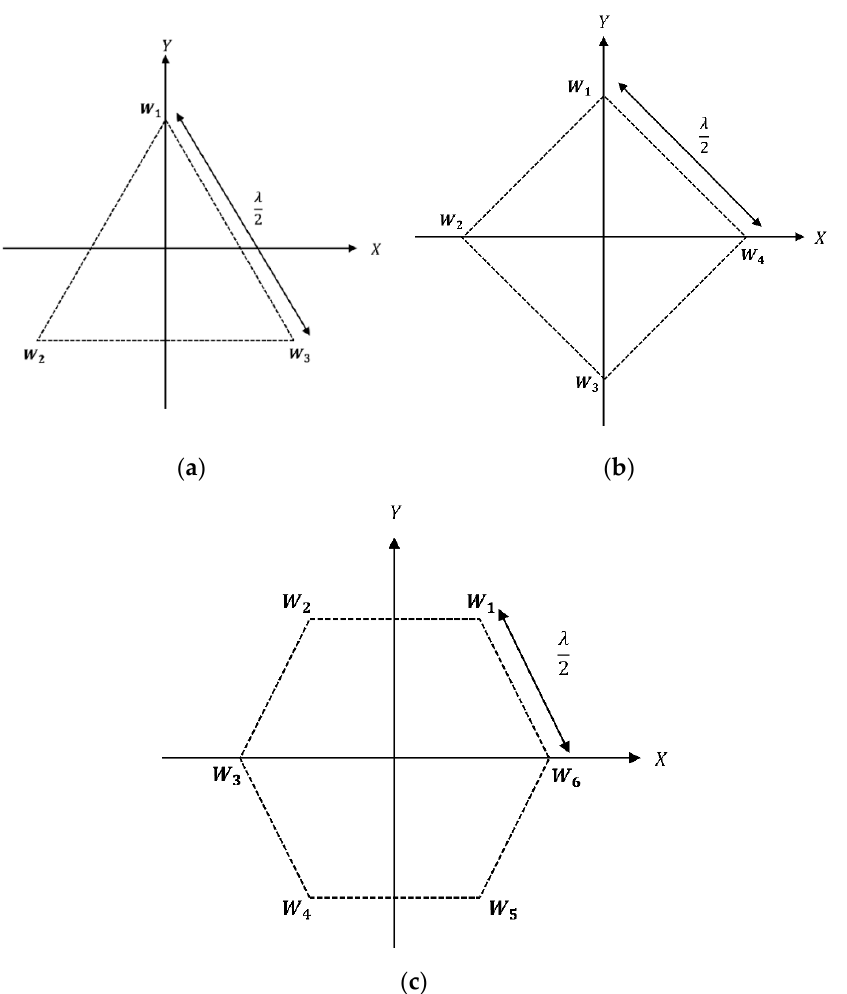
Figure 1. Schematic Diagram of Array Models proposed in [14] ( a ) Equilateral Triangular Configuration, ( b ) Square Configuration, and ( c ) Regular Hexagonal Configuration.